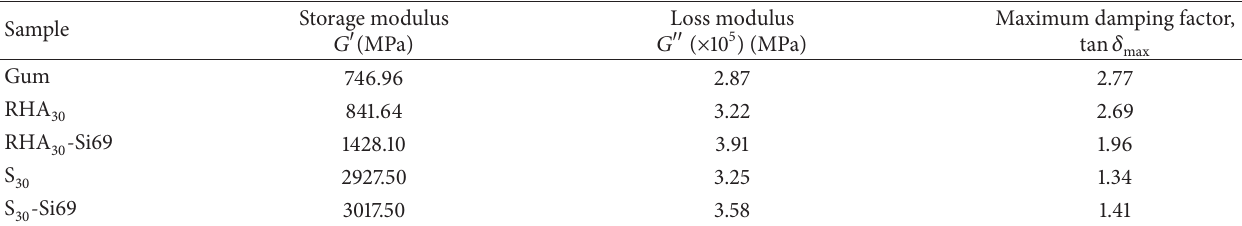
Table 5: Storage moduli at 20 ∘ C, loss moduli, and maximum damping factor of gum and filled ENR-25 vulcanizates with 30 phr of RHA or silica, with and without silane coupling agent